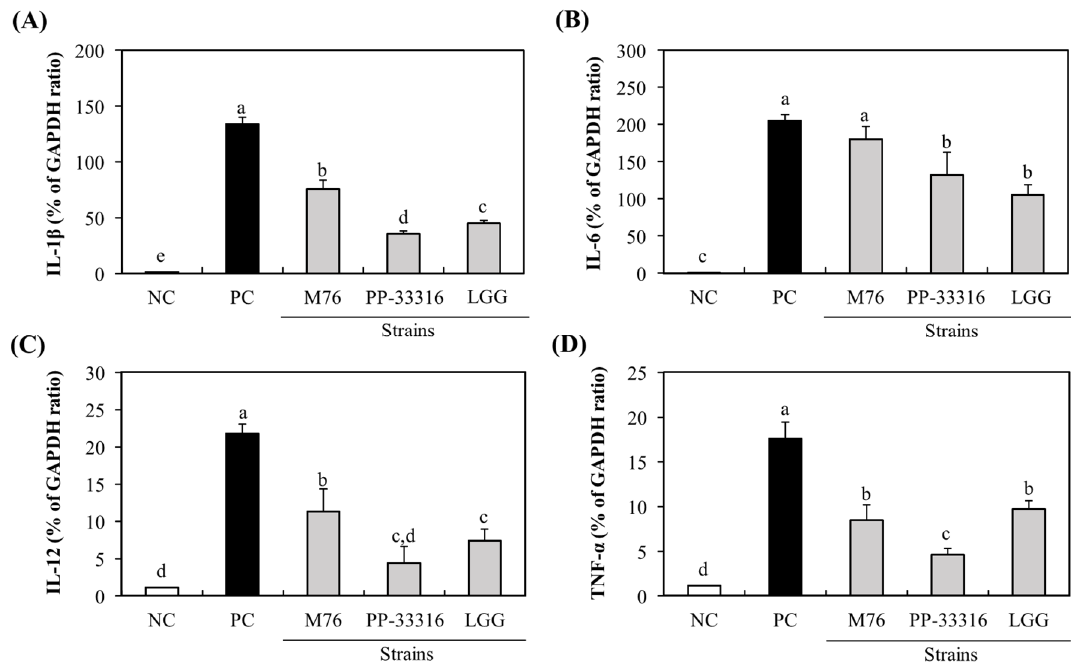
Figure 2. Effect of Pediococcus acidilactici M76 on mRNA expression levels of macrophage-activating factors, such as IL-1β ( A ), IL-6 ( B ), IL-12 ( C ), and TNF- α ( D ). RAW 264.7 cells were treated with different lactic acid bacteria (LAB) strain fractions for 24 h. Cells treated with media alone were used as the negative control (NC), cells treated with lipopolysaccharide (LPS, 1 µg/mL) were used as the positive control (PC). PA-M76, Pediococcus acidilactici M76; PP-33316, Pediococcus pentosaceus (ATCC 33316); LGG, Lactobacillus rhamnosus GG (ATCC 53103). a–e Means with different letters are significantly different ( p < 0.05).